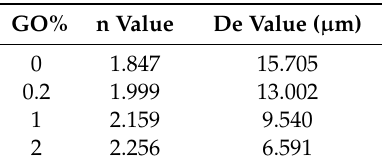
Table 2. Fitting results of CaCO 3 particle size